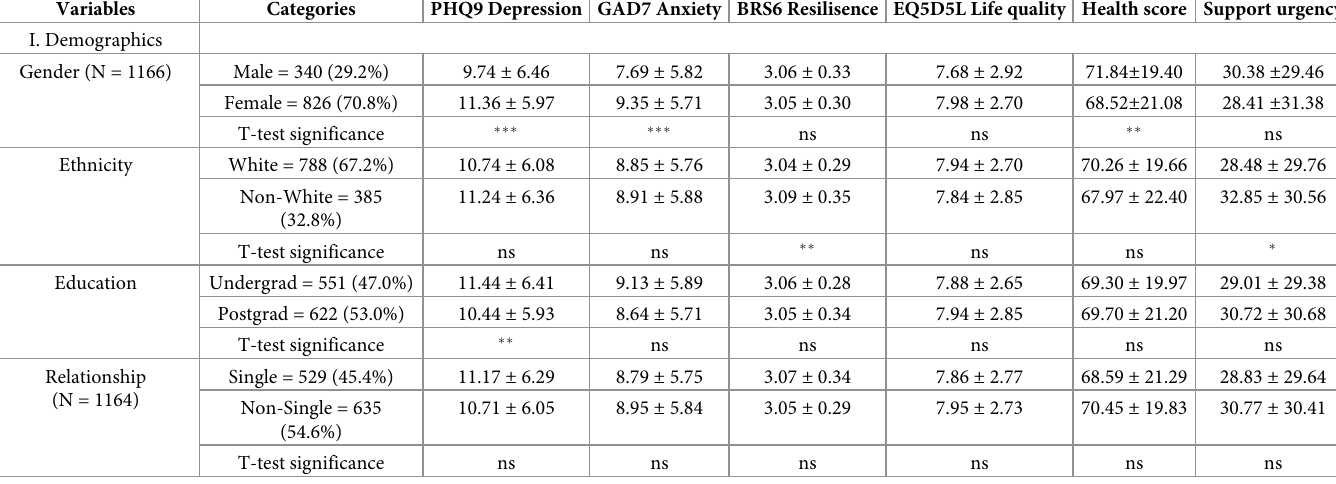
Table 6. Bivariate analysis on demographics.